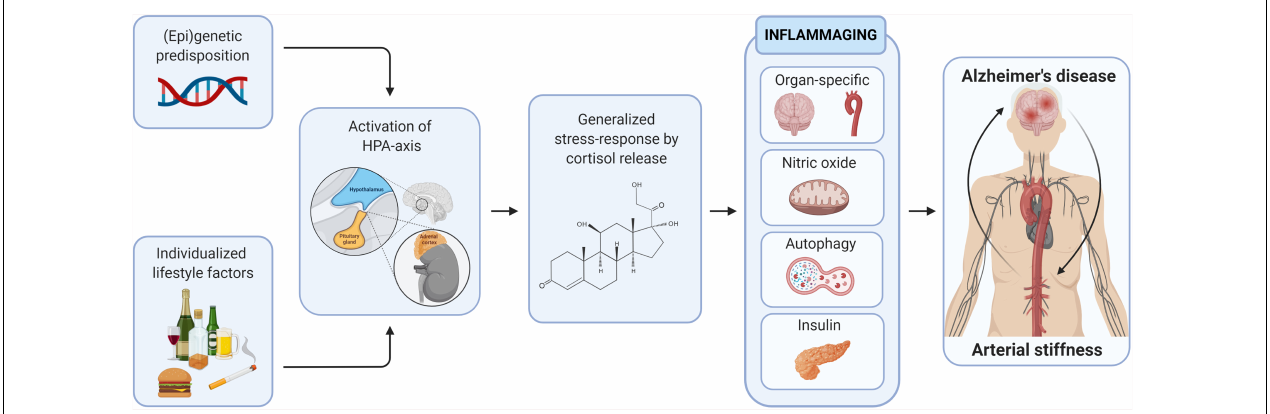
FIGURE 3 | Inflammaging as the mechanistic convergence between arterial stiffness and Alzheimer’s disease. The long-term causal effect of (epi)genetic predisposition and individualized lifestyle factors and consequent generalized stress-response on several inflammaging-related drives the mechanistic convergence between arterial stiffness and Alzheimer’s